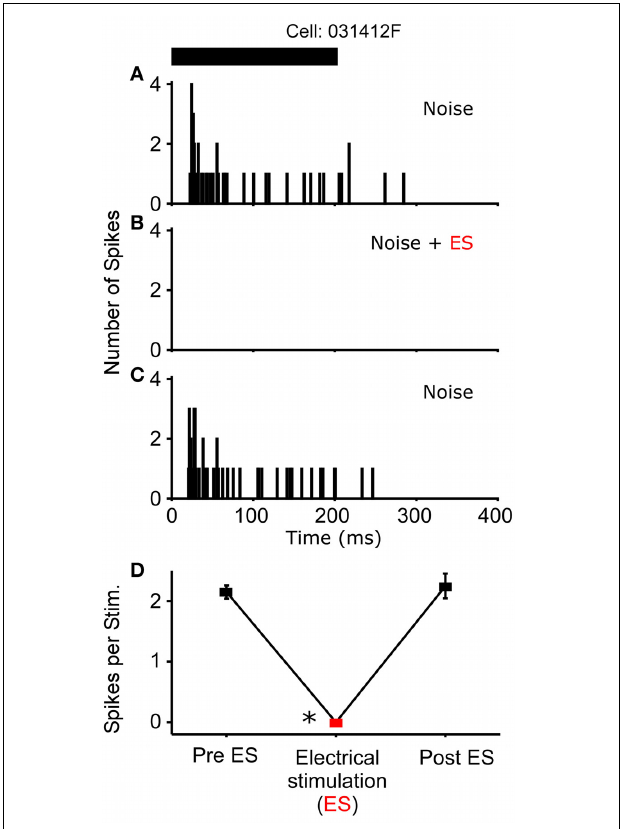
FIGURE 5 | One cell exhibited a complete loss of its auditory response during sound-by-sound electrical stimulation. Panels are as in Figures 3 , 4 . Asterisk notes statistically significant modulation.